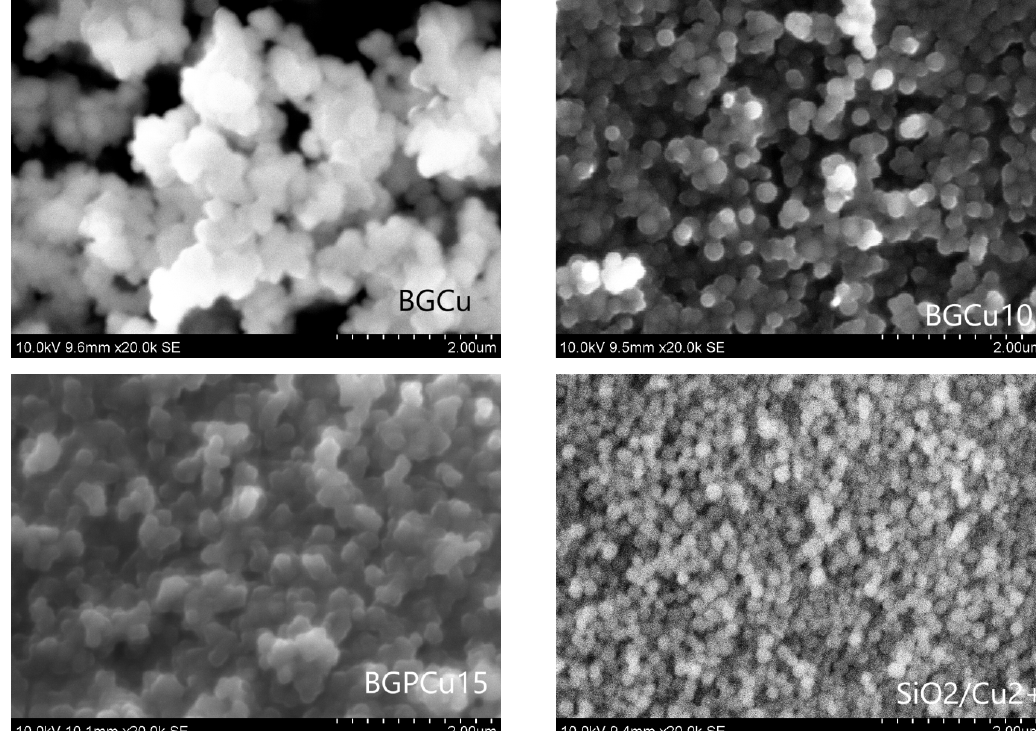
Figure 1. SEM micrographs of particles doped with Cu: BGCu, BGCu10, BGPCu15 and SiO 2 parti- cles impregnated in a solution of copper nitrate (SiO 2 /Cu 2+ ). Table 3. EDX analysis of the samples with Cu.